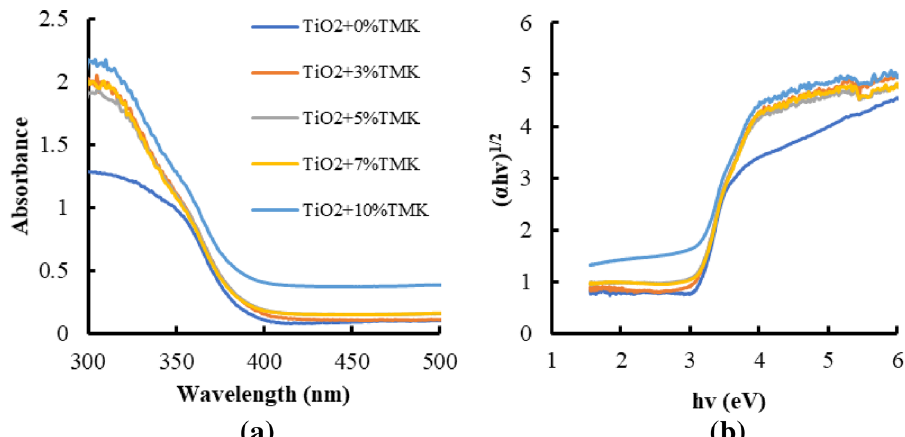
Fig. 3 Absorption spectra ( a ) and absorption spectrum fitting method using Tauc model of TiO 2 /TMK photoelectrodes